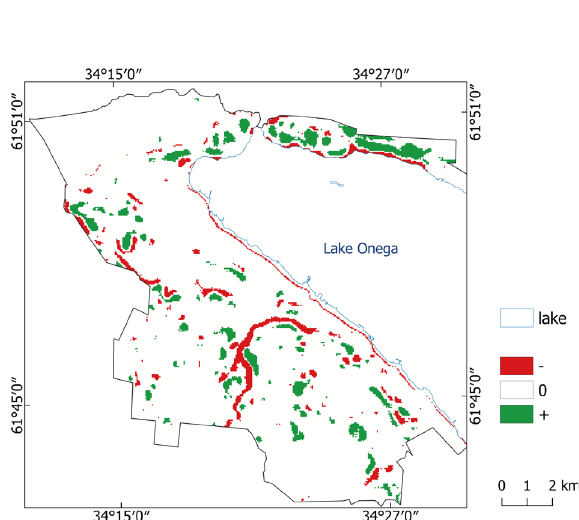
Fig. 6. Map of slope.